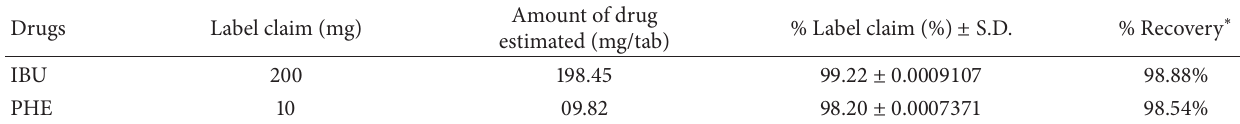
Table 1: Results of analysis of tablet formulation.